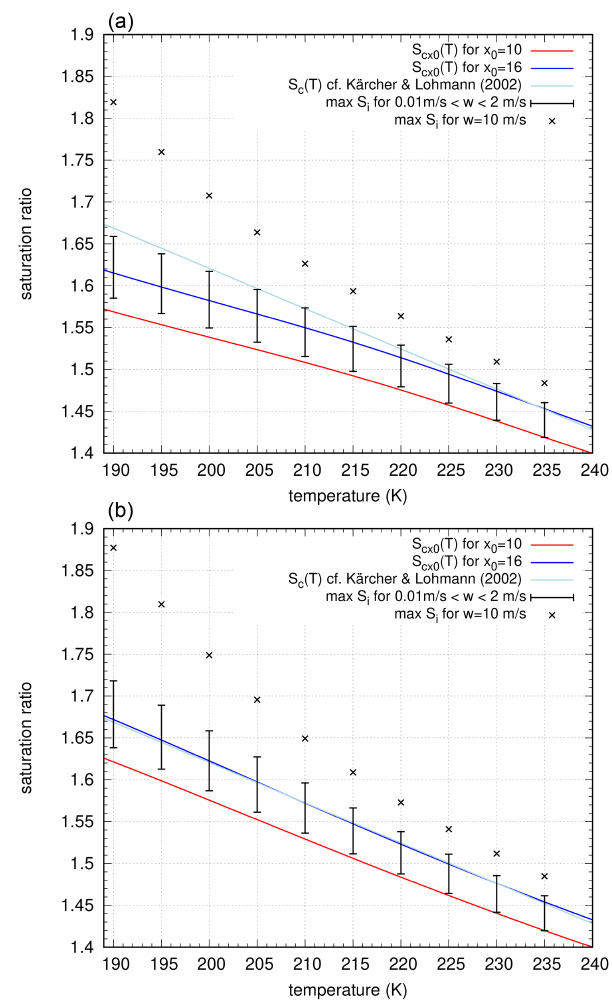
Figure 14. Same as in Fig. 13 but using the nucleation rate as em- pirically derived in Sect. 6.1. (a) Curves based on the water activity using the saturation vapour pressure formulation by Murphy and Koop (2005) and (b) the same for the saturation vapour pressure formulation by Nachbar et al.